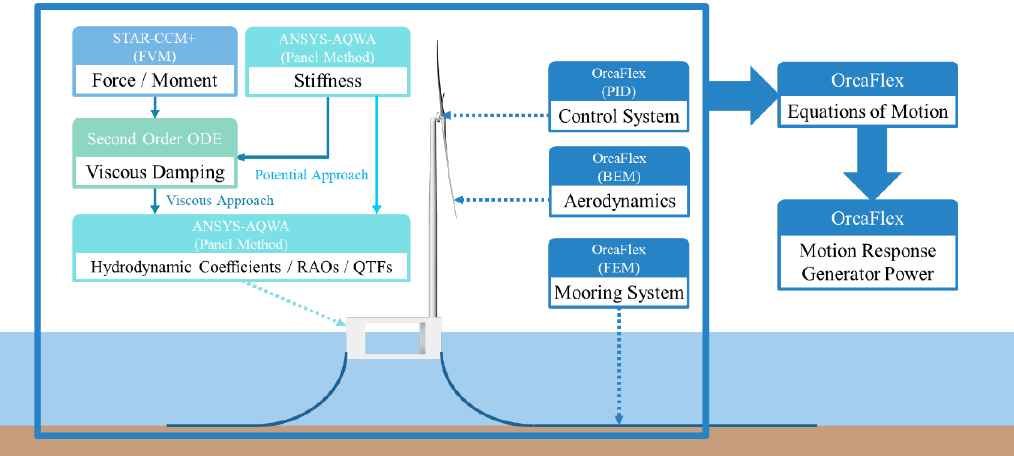
Figure 5. Numerical framework for floating wind turbine performance prediction.